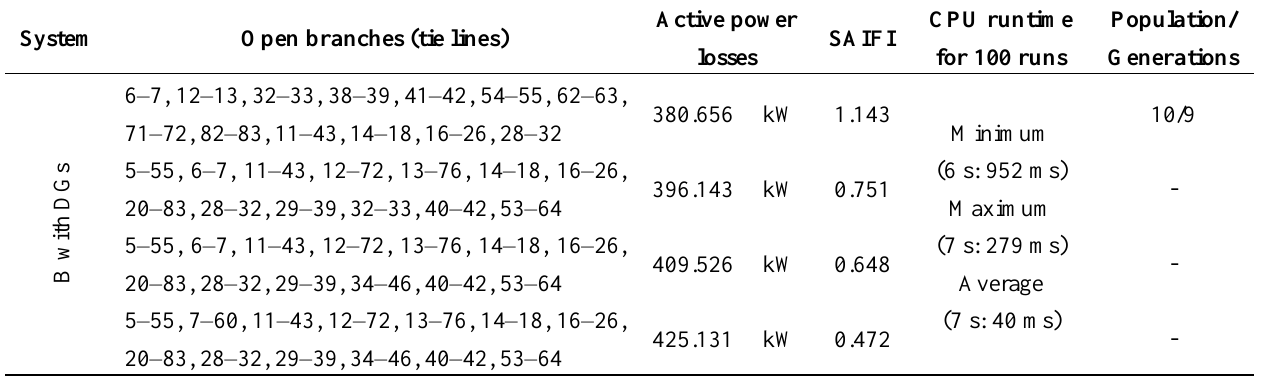
Table 2. Results for Pareto reconfiguration with two